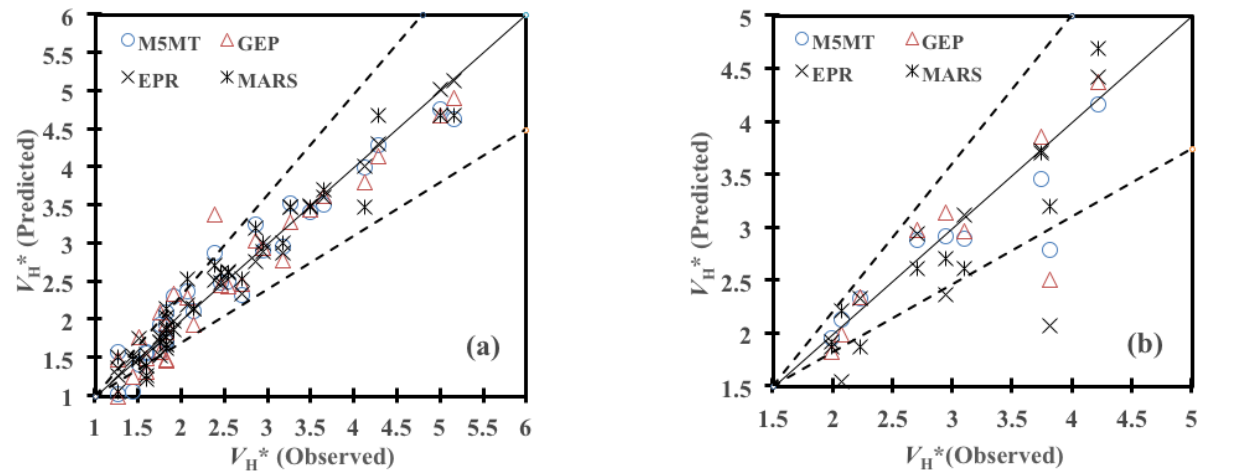
∗ for: ( a ) Training and ( b ) testing stage. H